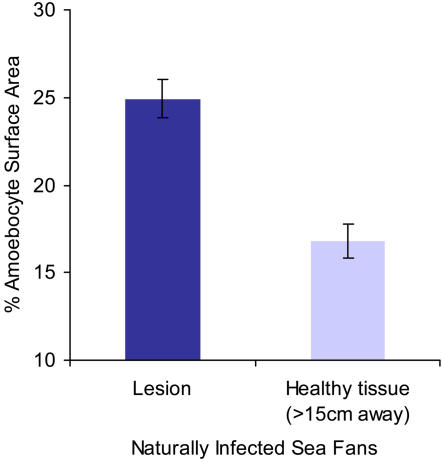
Amoebocytes are heterogeneously distributed within individual naturally infected sea fan colonies.Data presented are mean±s.e.m, n = 8, X
2 = 12.43, p = 0.0004.